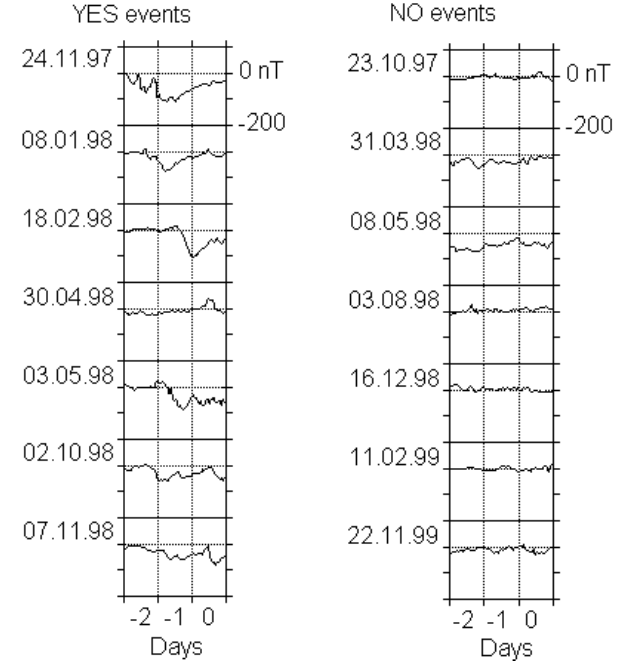
Fig. 10. Comparison of preceding geomagnetic activity for “YES events” and “NO events”. The day “0” means the day when SI response was